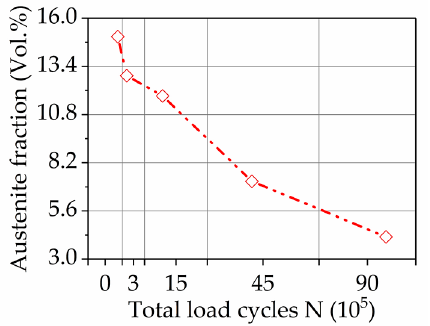
Table 2. Residual stresses and amount of retained austenite, measured by x-ray diffraction analysis for the different wear conditions. Figure 10. Austenite fraction of different wear conditions of gear teeth obtained by EBSD.